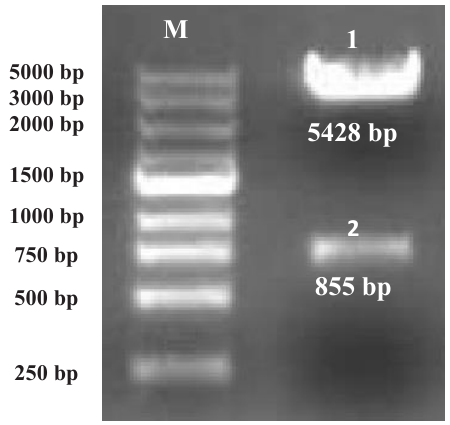
Figure 2. The restriction digestion of pcDNA3.1(+)- cagT recombinant plasmid constructs on 2% agarose gel electrophoresis. Note . Lane M is the 1 kb DNA ladder (Thermo Fisher Scientific, Freiburg, Germany). Fragments 1 and 2 were pcDNA3.1(+) vector and the exited cagT gene,